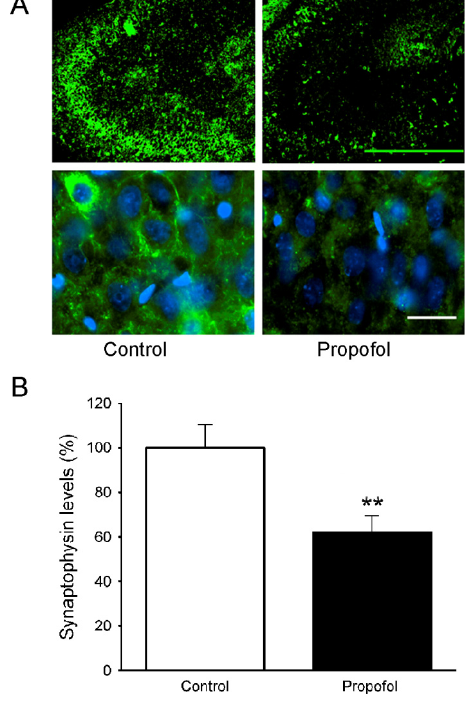
hippocampus of the offspring rats. ( A ) Immunofluorescent staining for synaptophysin in the brain tissues of offspring rats on P28. Left panel: control; right panel: propofol. Scale bar = 100 µm. ( B ) Semiquantitative analysis of the immunohistochemistry image shows that the synaptophysin levels in the brain of rats exposed to propofol in utero are significantly lower than that of control rats ( ** p = 0.009 significant difference from age-matched control group; N = 6 litters, 1 offspring per litter, n = 6 per